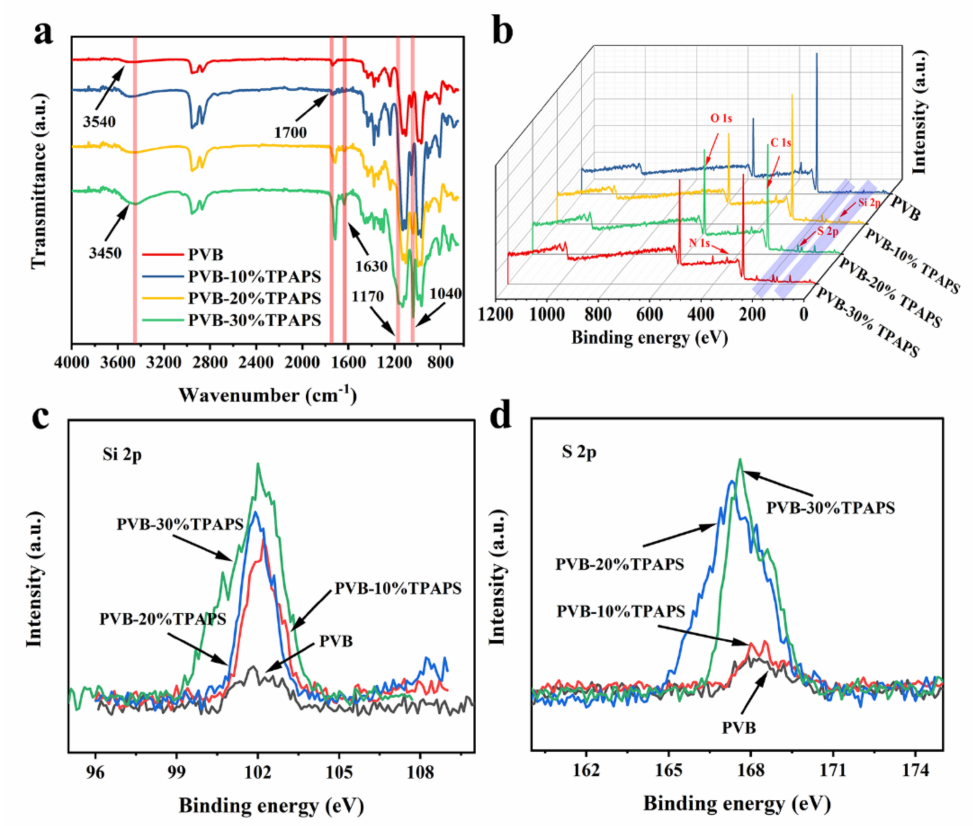
Figure 3. Analysis of the surface chemical composition of PVB-X% TPAPS coatings. ( a ) The FTIR spectrum, ( b ) the XPS full spectrum and fine spectrum of characteristic elements Si 2p ( c ) and S 2p ( d ),